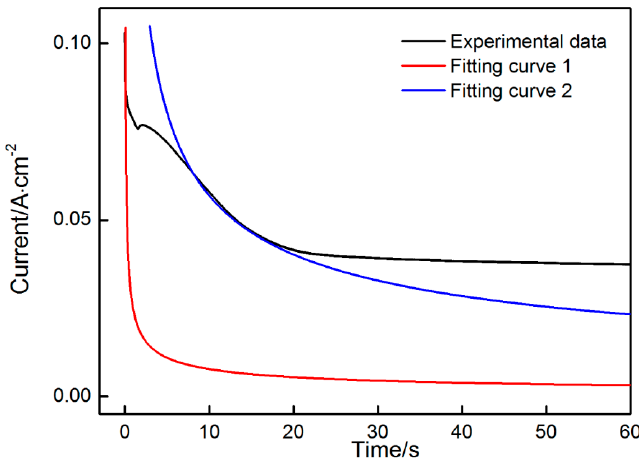
Figure 4. Fitting curves obtained at the first and third stages when a potential of 2.0 V was applied.